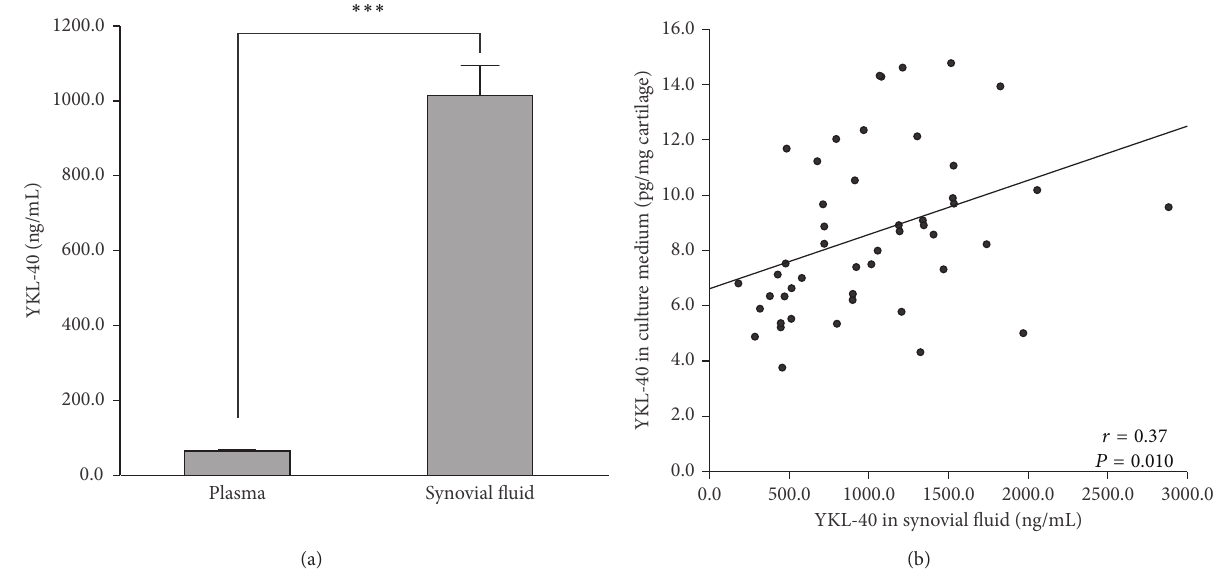
Figure 1: Concentrations of YKL-40 in OA synovial fluid were significantly higher than those in plasma and they correlated with YKL-40 released from cartilage in culture. (a) Mean concentration of YKL-40 in SF was 1027.9 ± 78.3 ng/mL and in plasma 67.2 ± 4.5 ng/mL. Results are presented as mean ± SEM. ∗∗∗ 𝑃 < 0.001 . (b) Scatterplot shows positive correlation between concentrations of YKL-40 in SF and those released into the culture media from OA cartilage during 42 h incubation ( 𝑟 = 0.37 , 𝑃 = 0.010 , 𝑛 = 48 ).